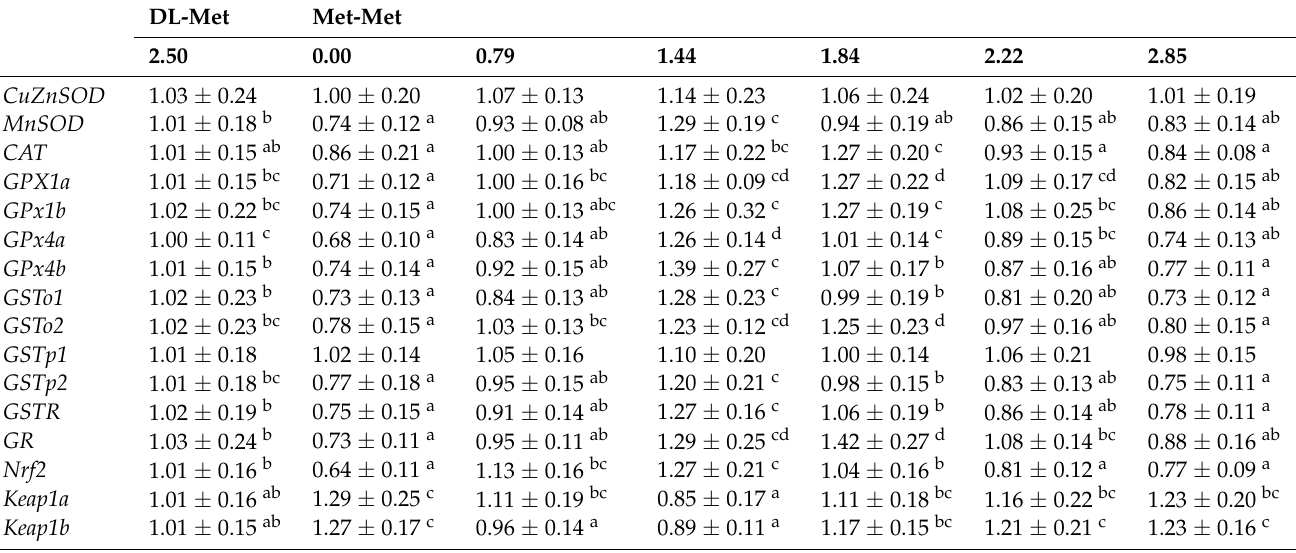
Table 6. Effects of dietary DL-Met and Met-Met supplementation (g/kg diet) on relative gene expressions of antioxidant enzymes and Nrf2 signaling in the distal intestine of juvenile grass